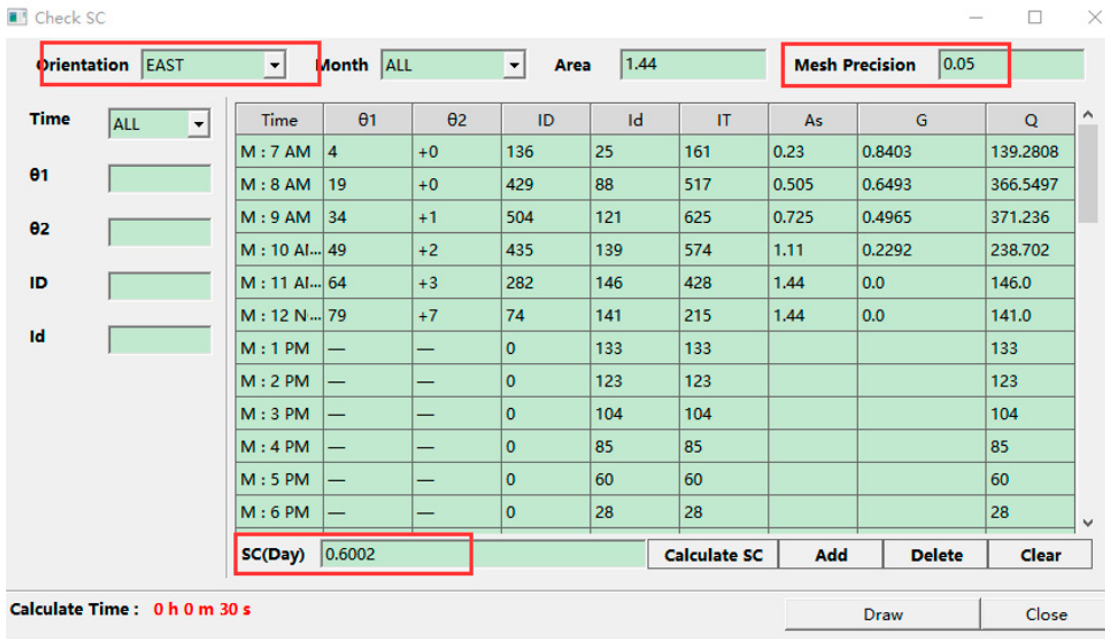
Figure 19. Mesh-shaped shading device.